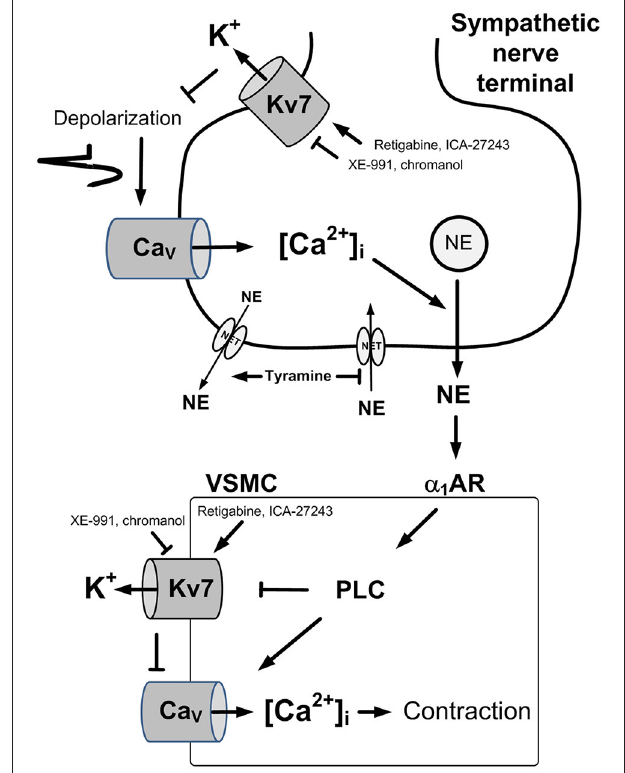
FIGURE 1 | Control of norepinephrine release and VSMC tension. A rise in [Ca 2 + ] i stimulates vesicular release of norepinephrine in sympathetic nerve terminals (Upper) and precipitates VSMC contraction through activation of myosin light chain kinase (Lower) . A rise in [Ca 2 + ] i occurs in the nerves in response to depolarization which activates the entry of Ca 2 + through L-type voltage-sensitive Ca 2 + (Ca v ). In VSMC, a rise in [Ca 2 + ] i occurs through activation of the PLC pathway, stimulated by for instance by the α 1 AR. The PLC pathway allows the release of Ca 2 + from intracellular stores (not indicated), or the entry of Ca 2 + through Ca v , either directly, or through depolarization following inhibition of Kv7 channels. Hyperpolarizing Kv7 channels will therefore stabilize both cell types and prevent transmitter release and VSMC contraction. Pointed arrows—stimulation. Blunted arrows—inhibition. NE, norepinephrine; NET, norepinephrine re-uptake